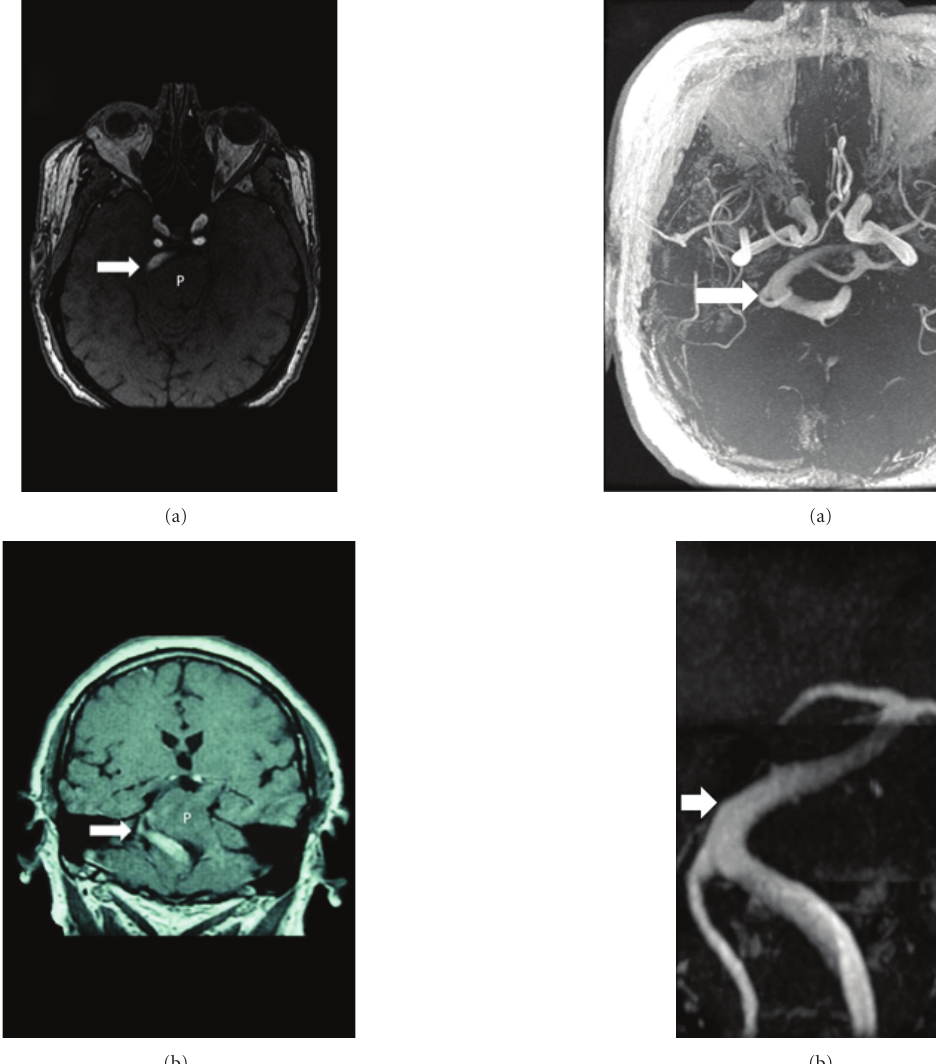
Figure 1: Neurovascular conflict: (a) (axial) and (b) (coronal) MRI reconstruction from a 3D-FSPGR study shows a dolichoectatic basilar artery (arrow) crossing and displacing upper pons (P) with compression of the right trigeminal nerve at the root entry zone.